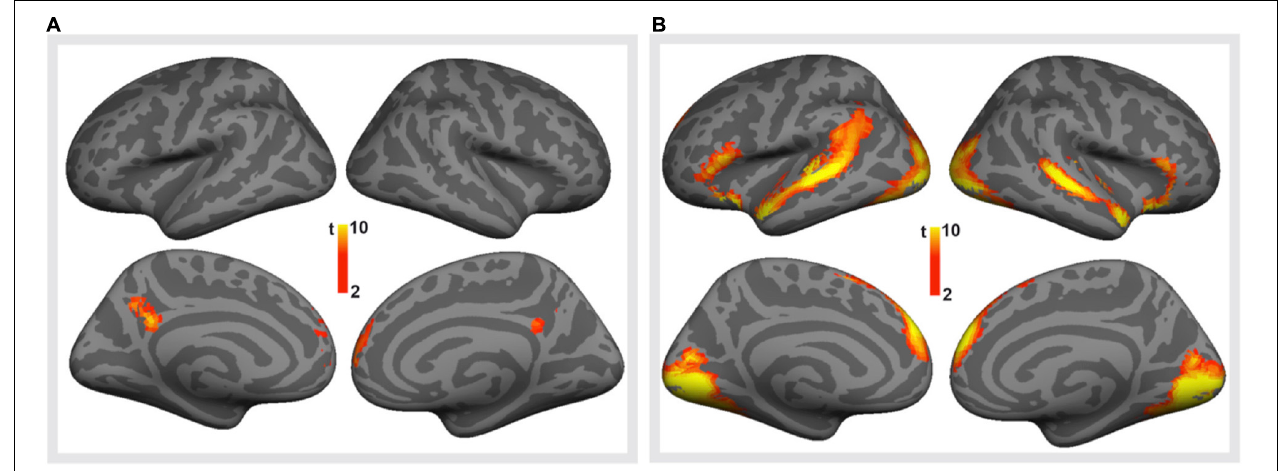
FIGURE 3 | Brain responses to emotionally valenced vs. neutral stimuli. (A) Brain regions showing significantly stronger activity in response to viewing controversial (valenced) statements than to viewing neutral statements. (B) Brain regions showing on average significantly stronger activity in response to positive or negative peer feedback (i.e., valenced feedback) than to neutral feedback. Voxel-level family-wise error corrected p < 0.05, cluster size > 100 voxels for both.